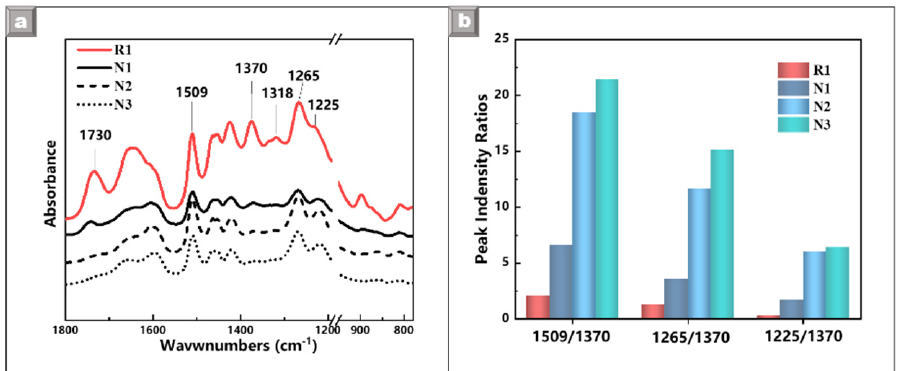
Figure 8. FT − IR spectra ( a ) and characteristic absorption peak intensity ratio ( b ) of the archaeological